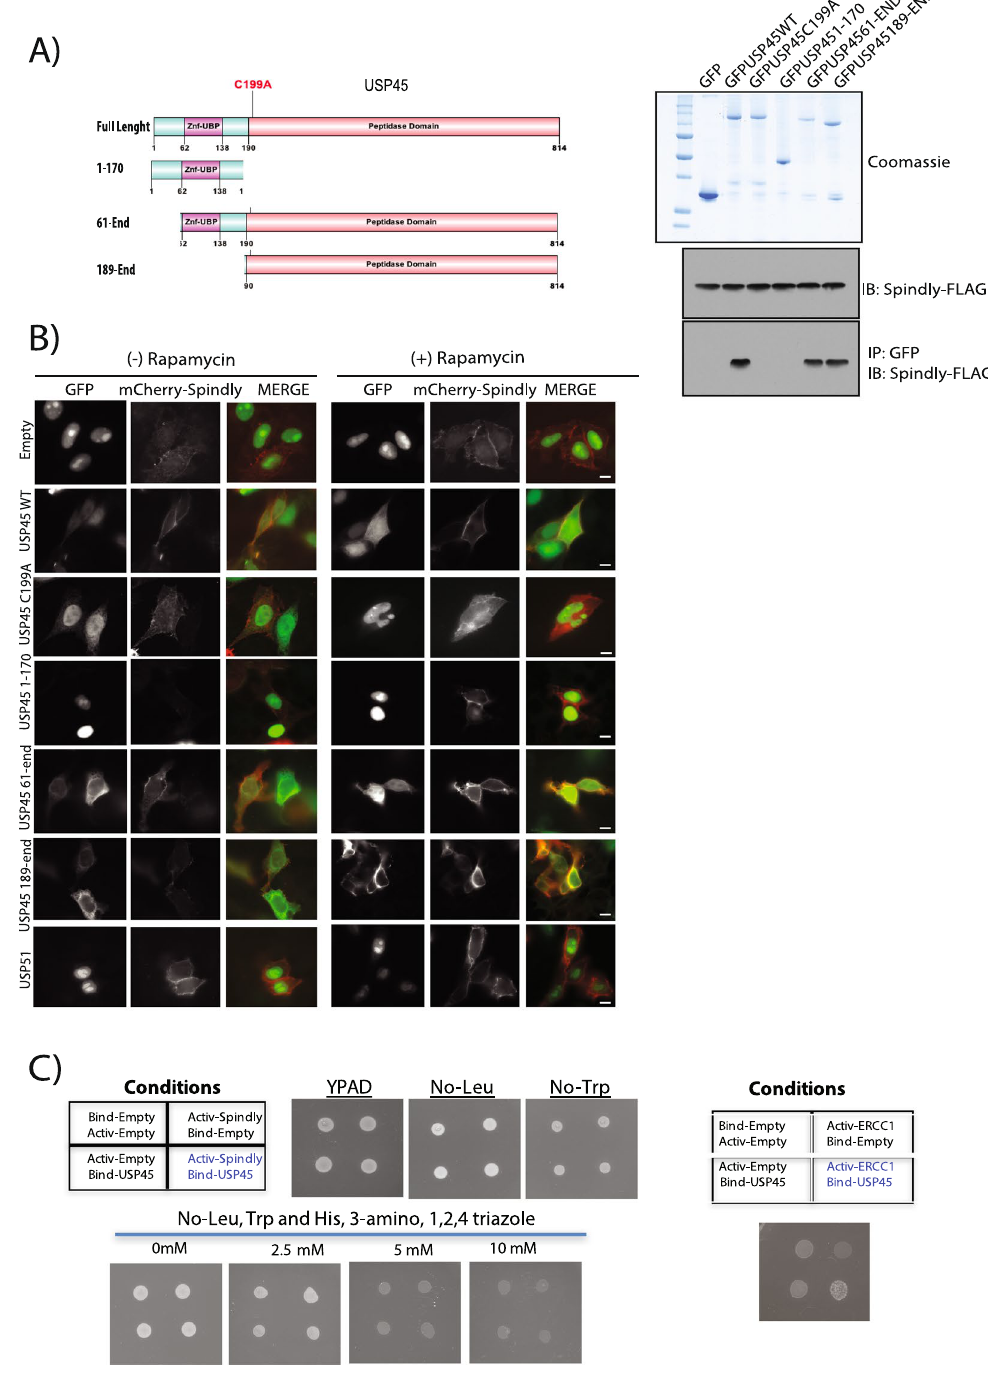
Figure 2. The catalytic activity of USP45 is essential for its interaction with Spindly. ( A ) U2OS cells were transiently transfected with the indicated GFP fusion constructs encoding full-length or indicated fragments of USP45 (left-hand side panel). Thirty six hours post-transfection cells were lysed and GFP immunoprecipitated. The immunoprecipitates were resolved on a polyacrylamide gel and stained with Coomassie (right-hand side upper panel) or subjected to immunoblotting with the indicated antibodies (right-hand side lower panel). GFP empty vector was used as a negative control. ( B ) U2OS cells were transfected with the indicated USP45 constructs GFP tagged, mCherrySpindly-FKBP and Lin11-FRB for 40 hours. Lin11 expression allows for mislocalisation recruitment at the plasma membrane of the FKBP- tagged protein. Rapamycin (4 μ M) was administered for 1 hour (at 37 °C) and then cells were visualized under a fluorescence microscope: USP45 construct (green), Spindly (red). Left-hand side panel DMSO treated samples; right-hand side Rapamycin treated samples. 60X magnification. Scale bars: 5 μ m. GFP-USP51 was used as negative control. ( C ) Yeast two-hybrid (Y2H) assays were performed with a GAL4 DNA-binding domain fusion or activation domain for each protein indicated in the table to detect interaction